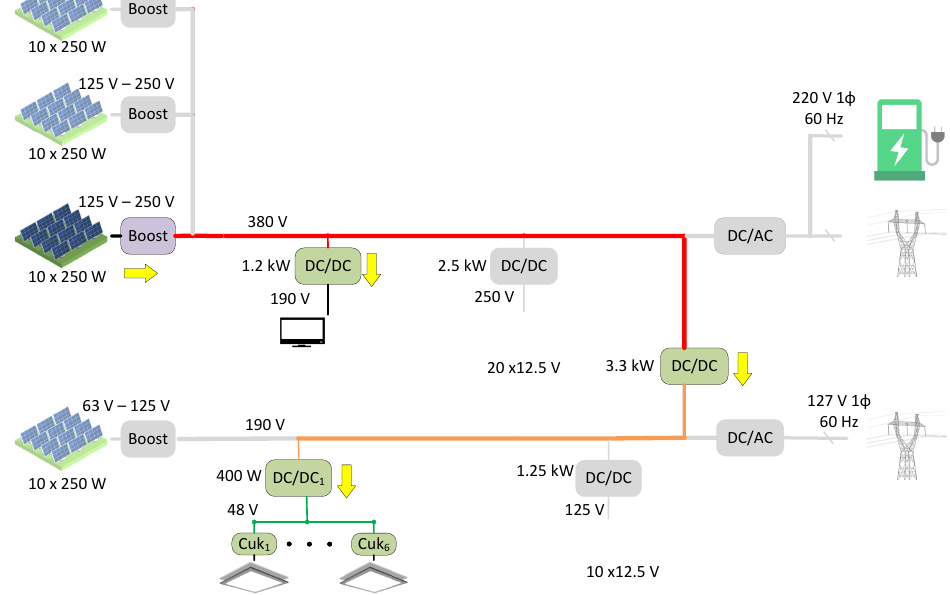
Figure 26. First test trajectory for DCMG multibus multi-voltage operating with only one boost converter.